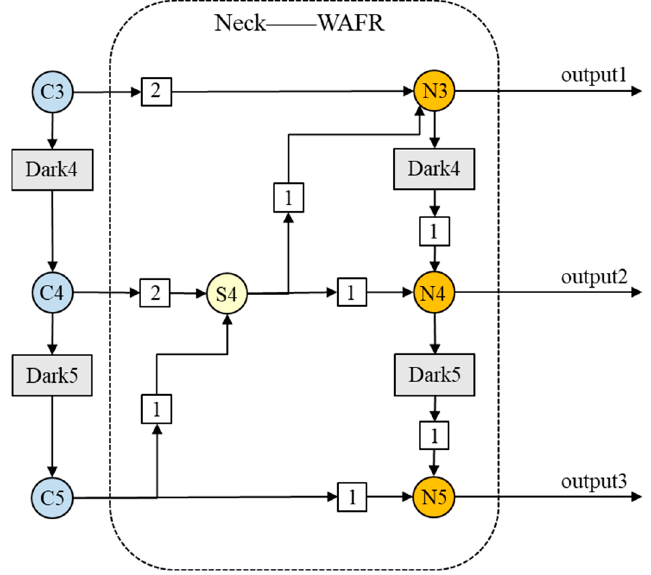
Figure 11. Weighted aggregation feature e-extraction pyramid (WAFR). In the figure, layer C5 is the deepest output of the backbone network, which has the most semantic information. Layer N3 is a top-down fusion feature map. Layers N4 and N5 are feature maps after re-extraction and cross-fusion of backbone network features.